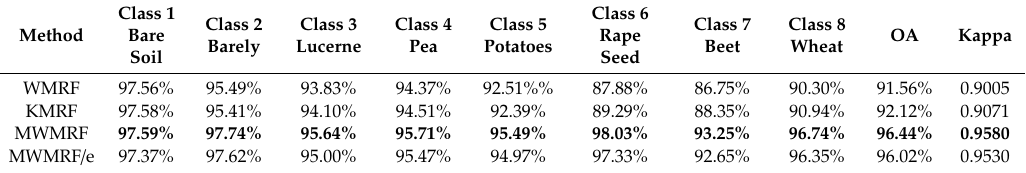
Table 2. Comparison of the pixel-based classification algorithms for the Wallerfing